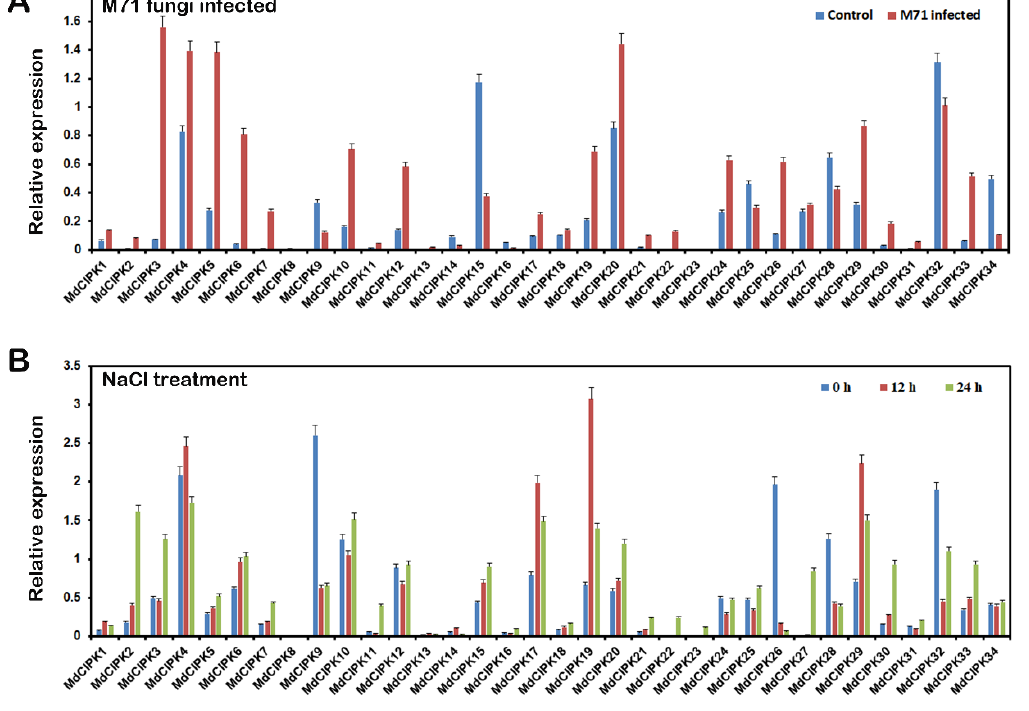
Figure 7. Expression profiles of MdCIPK genes under fungal and salt stresses. Shoots with young leaves for fungal treatment and the water used as a control ( A ) or exposed to MS solution containing 100 mM NaCl for salt treatment ( B ) and the samples used for RT-qPCR analysis.